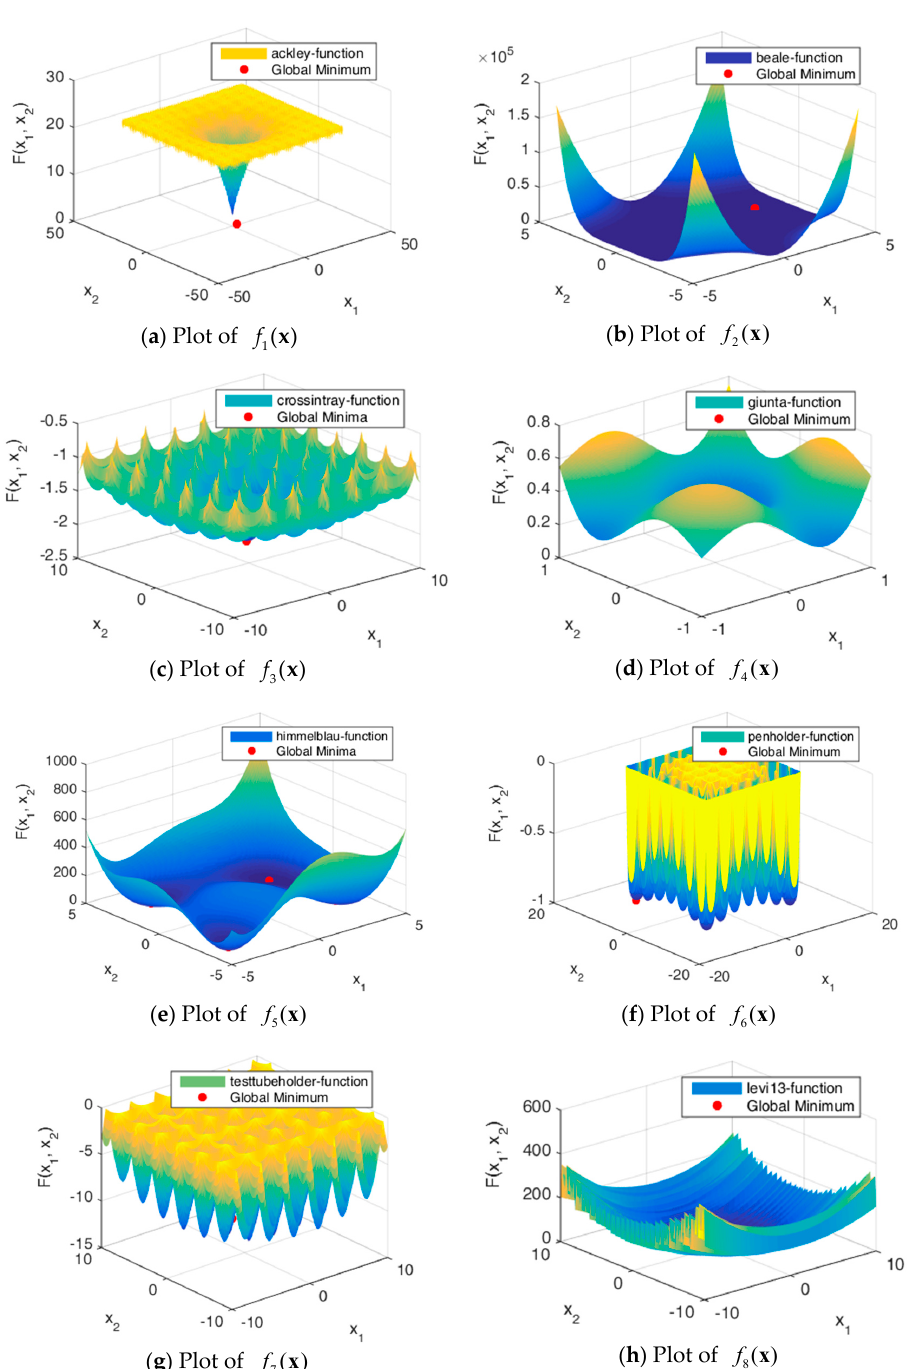
Figure 5. Plots of benchmark functions. Table 3. Parameter setting for GA, PSO, DE, and